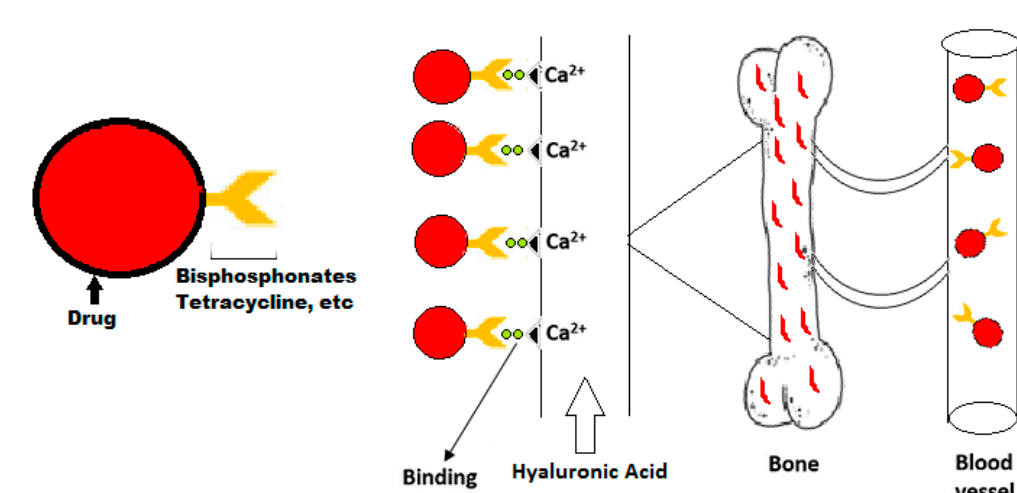
Figure 4. Schematic graph of delivery of bone specific drugs.